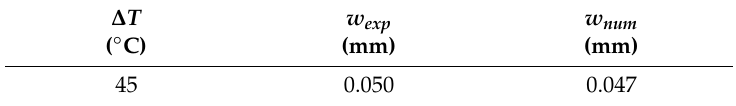
Table 2. Maximum crack opening obtained numerically and